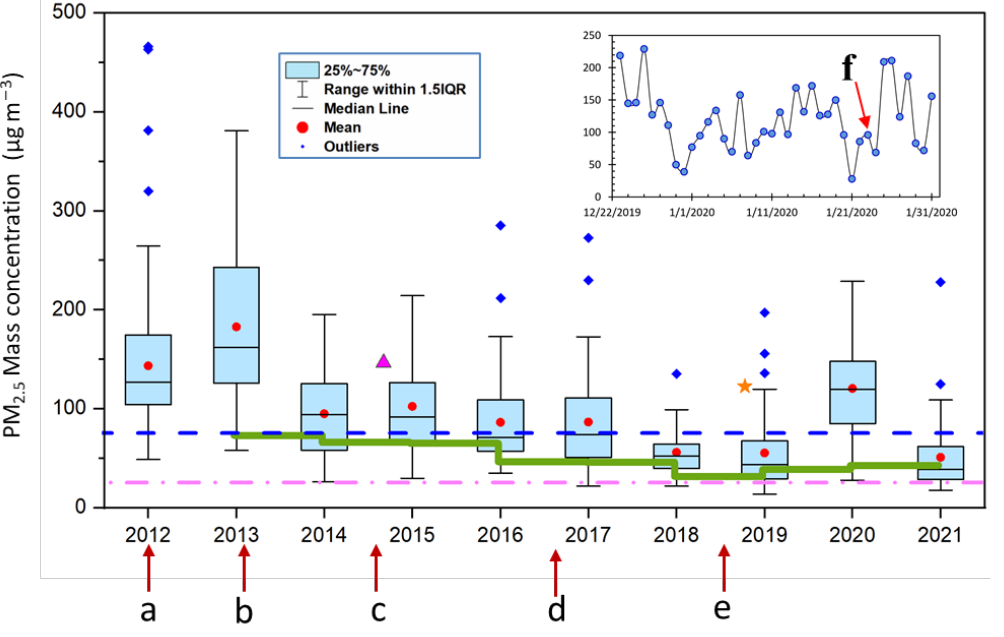
Figure 8. Long-term variations of PM 2.5 concentrations in periods from 23 December to 31 January next year (box plots), year-round averages of PM 2.5 concentrations (solid green line), and other published PM 2.5 concentrations from Fang et al., 2017 (pink triangle) and Bai et al., 2020 (orange star). Letters below the x axis indicate related events: a. The observation campaign was conducted from 23 December 2011 to 31 January 2012 (this study); b. Implementation of the new released China’s Air Quality Standard in 2013, which included PM 2.5 as a new criterion pollutant for the first time; c. Action Plan of Air Pollution Prevention and Control in 2014.6; d. Clean Air Action Plan in 2016.7; e. Three-Year Blue Sky War in 2018.9; f. The day (23 January 2020) when Wuhan, China released announcement of lock-down due to the COVID-19 epidemic.